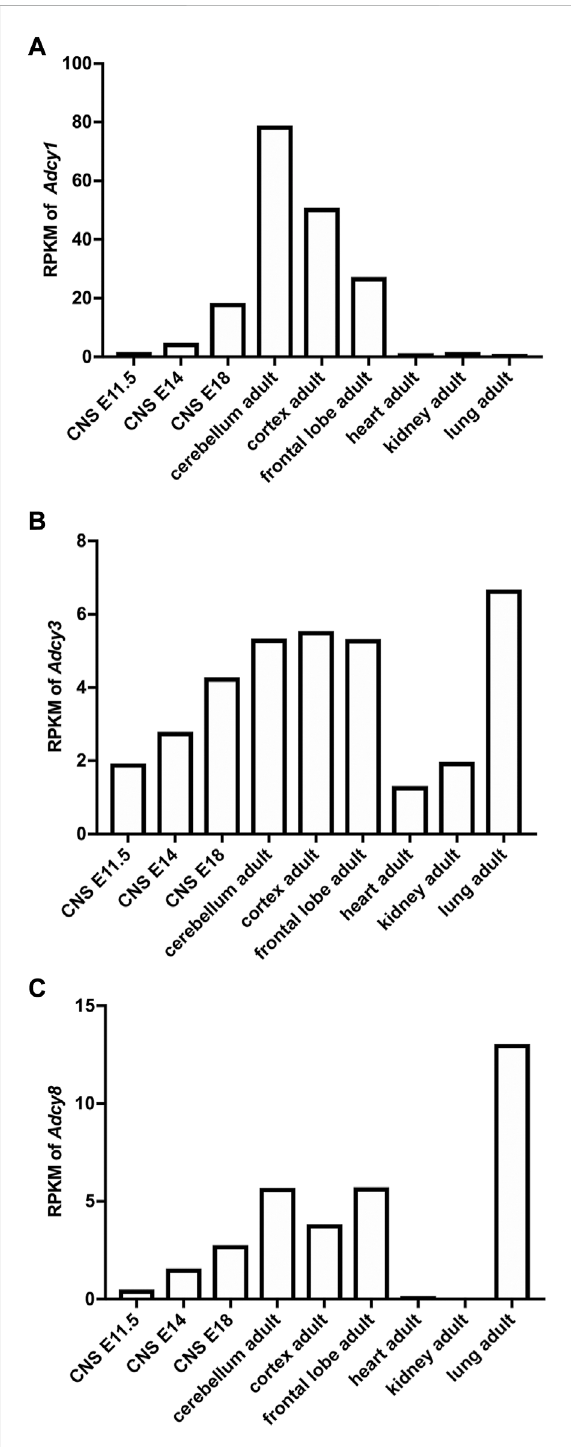
FIGURE 2 Developmental and tissue-speci fi c expression of Ca 2+ - stimulated Adcy mRNAtranscriptsinmouse.TheRNAseqstudybythe MouseENCODEConsortium(Yueetal.,2014)revealedtheexpression of Adcy1 (A) , Adcy3 (B) , and Adcy8 (C) mRNA in different tissues and in CNS at different developmental stages. RPKM: Reads Per kilobase of transcript per Million mapped reads. CNS: central nervous system. E11.5, E14, and E18: embryonic day 11.5, 14, and neurons,